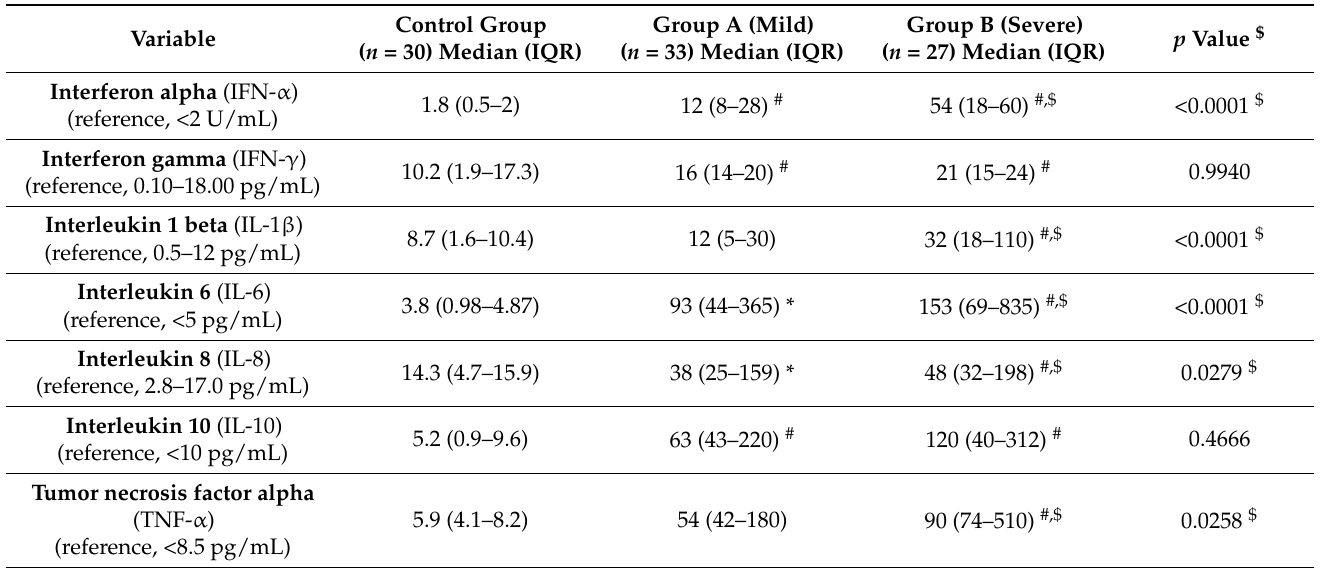
Table 4. Assay of cytokines on Day 1 after admission with MIS-C